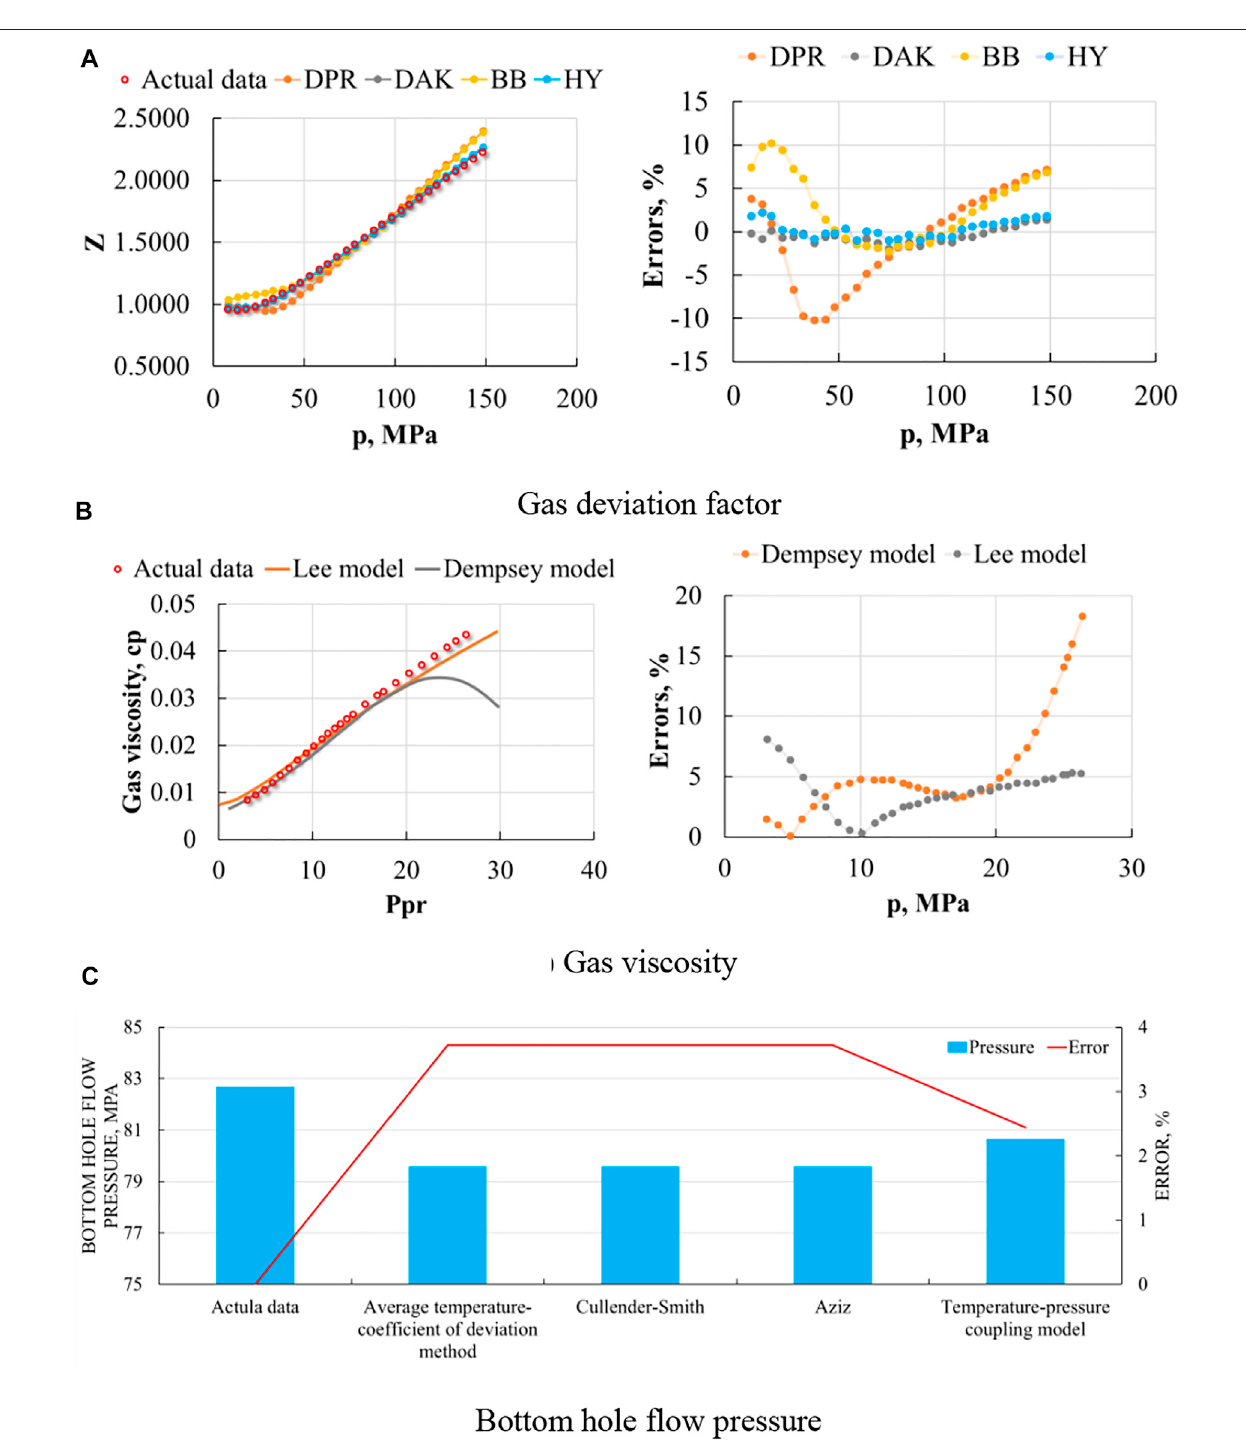
FIGURE 1 | The in fl uences of fl uid and engineering properties on calculating results and errors for high-pressure and high-temperature condensate gas reservoirs (data from Yang et al., 2019; Peng et al., 2017). (A) Gas deviation factor. (B) Gas viscosity. (C) Bottom hole fl ow pressure.